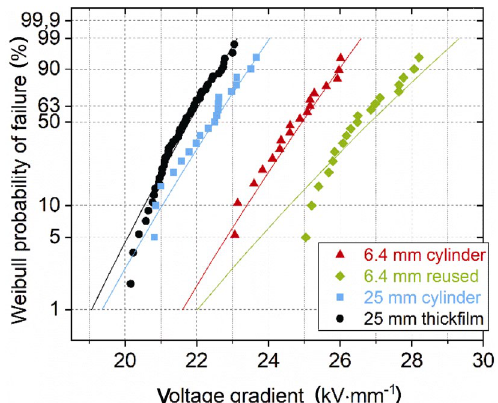
Fig. 7 Weibull probability grid plot of dielectric strength (AC) of 620 µm Al 2 O